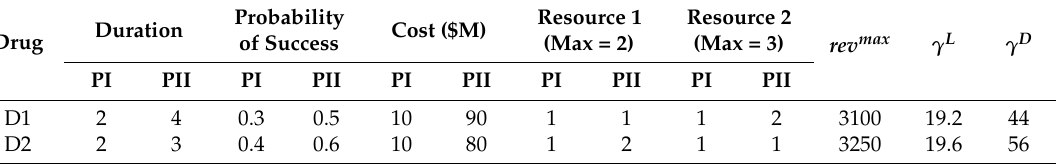
Table A1. Parameters of the two-drug case study.